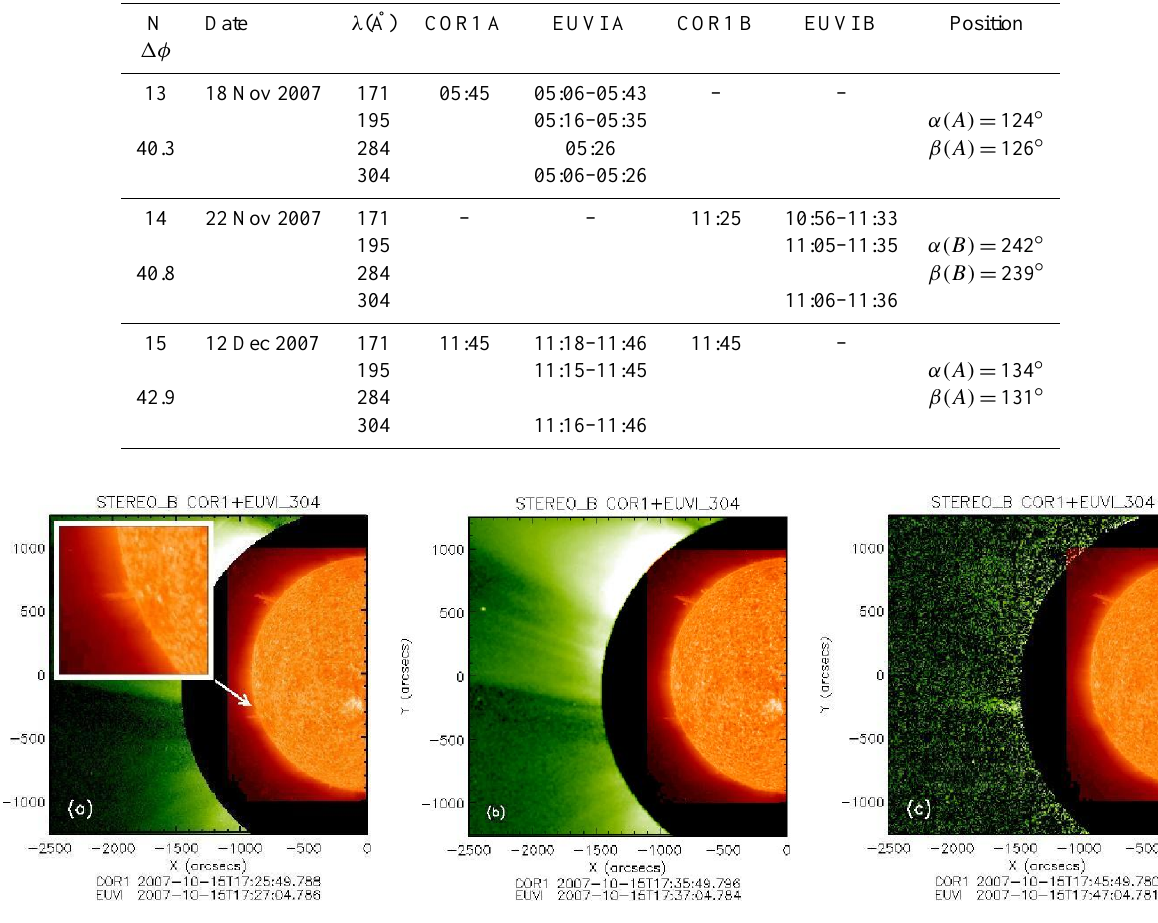
Fig. 1. Example of an EUV equatorial jet and its counterpart in the COR 1 field of view as seen by STEREO B on 15 October